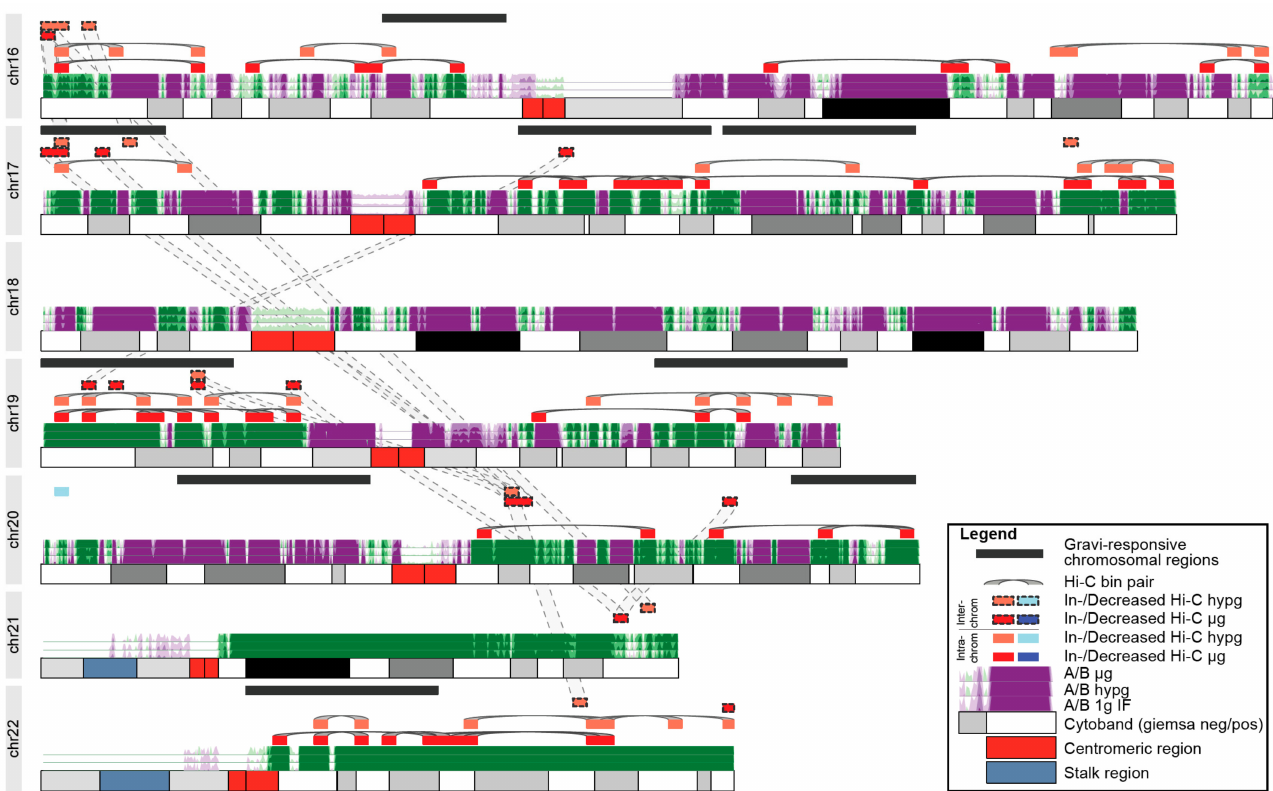
Figure 8. Overlap between gravity-responsive transcriptional regions from clustering correlation analysis (both 23rd DLR PFC comparisons had a transcriptional binning average for these sites) and significant differential Hi-C bin pairs. Hi-C bin pairs are linked by grey curves. The A/B compartments are highlighted for all three in flight conditions, with 1gIF, hypg, and µ g in ascending order. Here, the chromosomes with the majority of differential interaction sites are shown (chr16–22). The full genome is shown in Supplementary Figure S10. The non-randomness of Hi-C bins towards differential transcription clusters over the entire genome was assessed with a Fisher’s exact test as 4.7 × 10 − 5 for hypg vs. 1gIF and as 1.3 × 10 − 9 for microgravity vs.